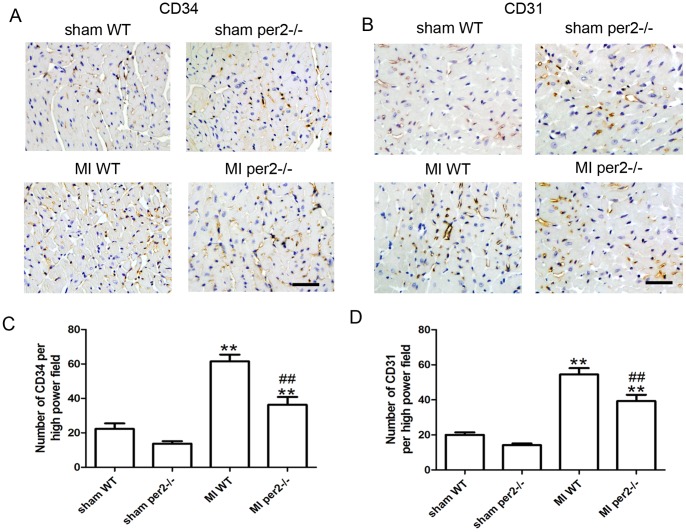
Per2−/− decreased the number of CD34+ progenitors and capillary density in mice.(A) Representative immunostaining of CD34 to identify progenitors and (B) CD31 to identify capillaries. Original magnification: 400×. Quantitative analysis of (C) CD34+ cells and (D) capillary density (** p<0.01 vs sham-operated, ## p<0.01 vs MI WT).